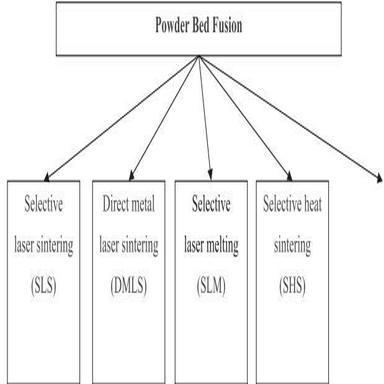
Different Powder bed fusion techniques used in additive manufacturing.